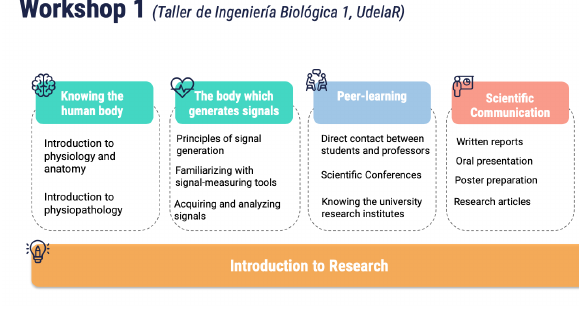
Figure 2. Modular vision of the new